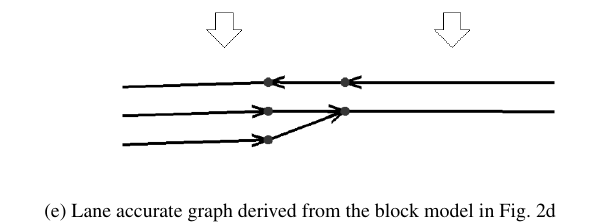
Figure 2. Examples of specified block